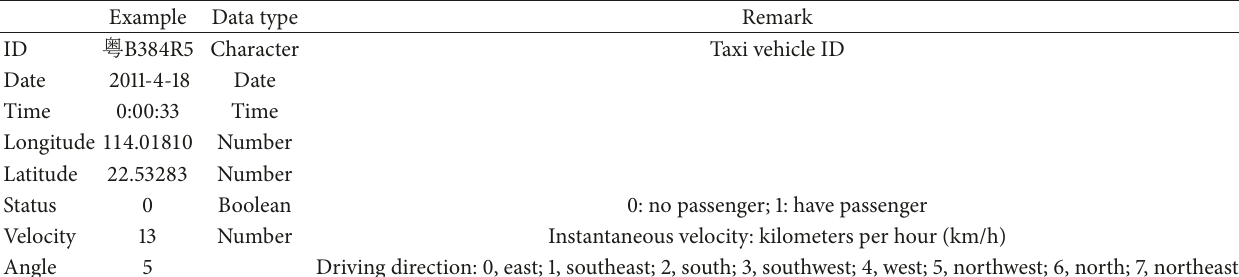
Table 1: An example trace of taxi GPS data, using the same vehicle as the